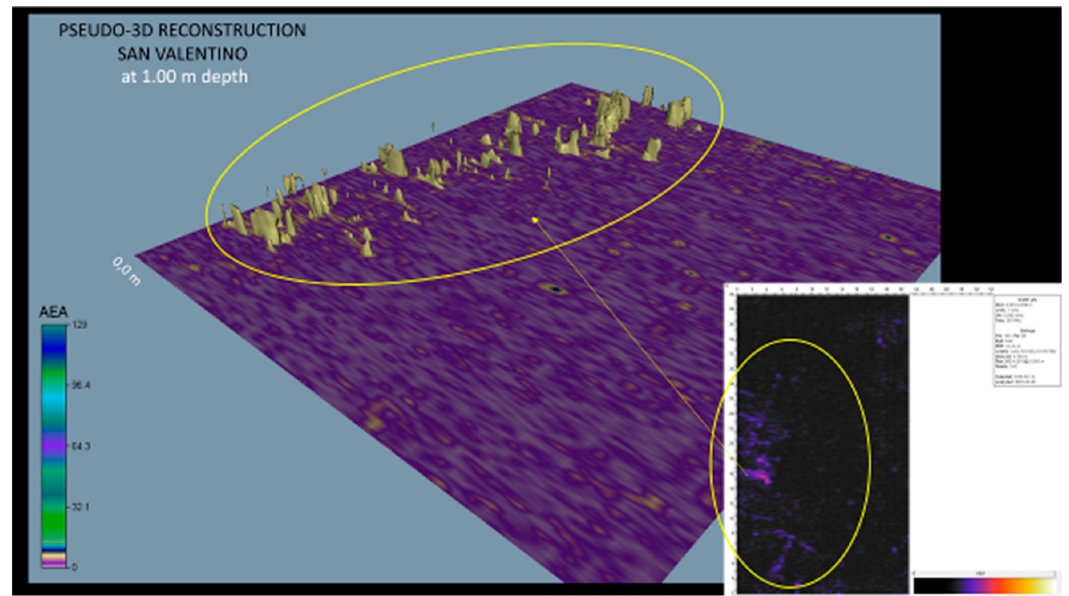
Figure 9. The pseudo-3D reconstruction of the anomalies identified by the linked map (bottom right) at a depth of up to 1 m.